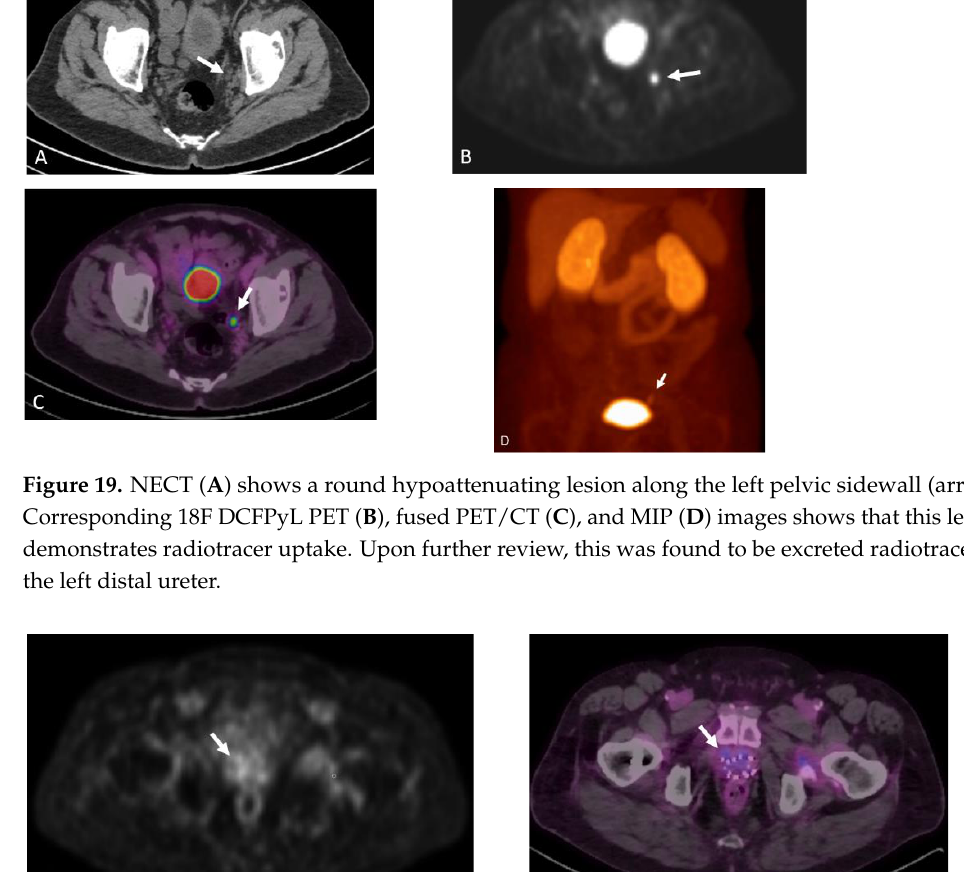
Figure 20. Sixty-four-year-old male with history of prostate cancer, status post-brachytherapy, presenting with rising PSA level. 18F DCFPyL PET ( A ) and fused PET/CT ( B ) images show multifocal radiotracer uptake in the mid-prostate gland (arrows). This uptake subsequently resolved on the follow-up scan (not shown). It was later revealed that the patient had undergone a transrectal prostate biopsy three weeks prior to our study, confirming the uptake to be secondary to inflammation from the recent biopsy.